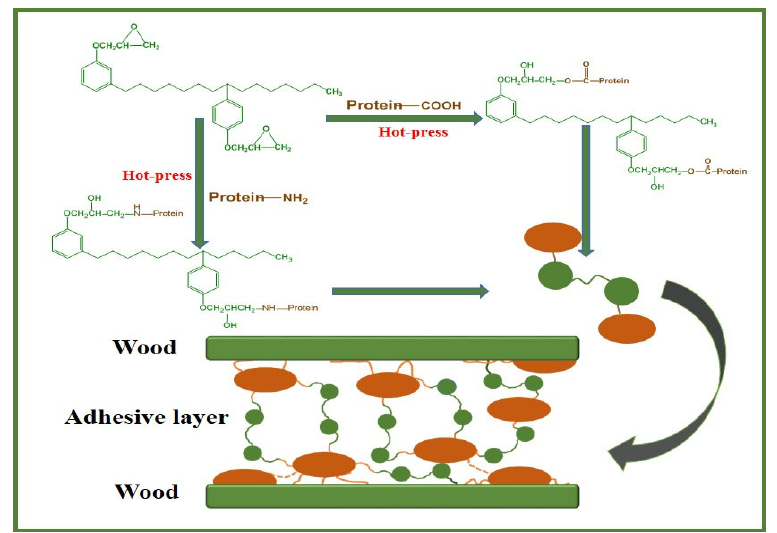
Figure 3. Possible reaction in the curing process of soybean protein ‐ based adhesives.